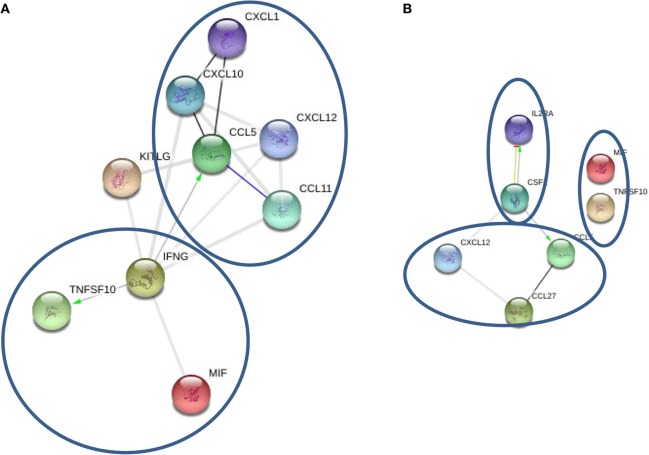
STRING cytokine analysis of cerebrospinal fluid (CSF) based on the presence of oligoclonal bands. (A) Oligoclonal positive patients (CSF2 = GM-CSF). (B) Oligoclonal band negative patients (*P < 0.01; **P < 0.001; ***P < 0.0001).